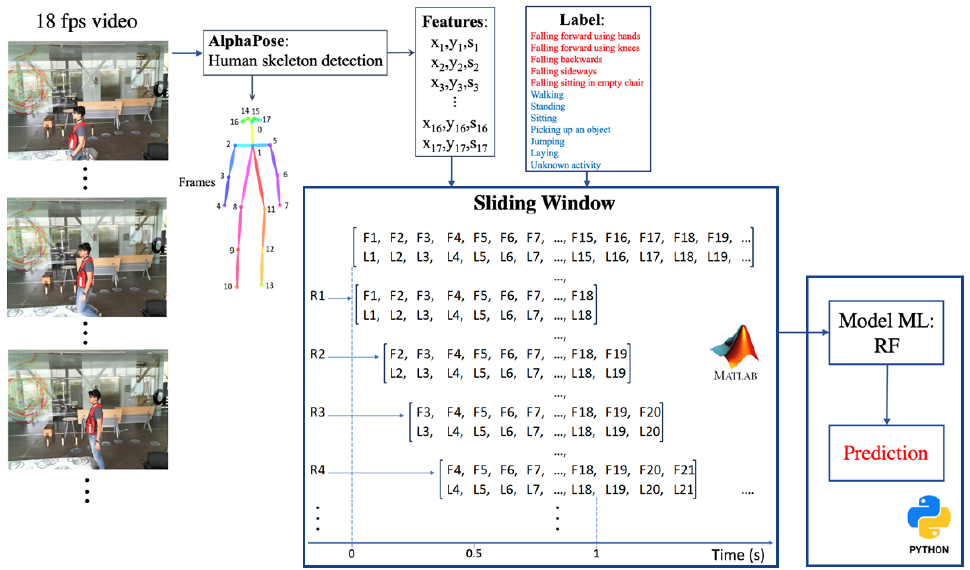
Figure 1. Workflow for activity